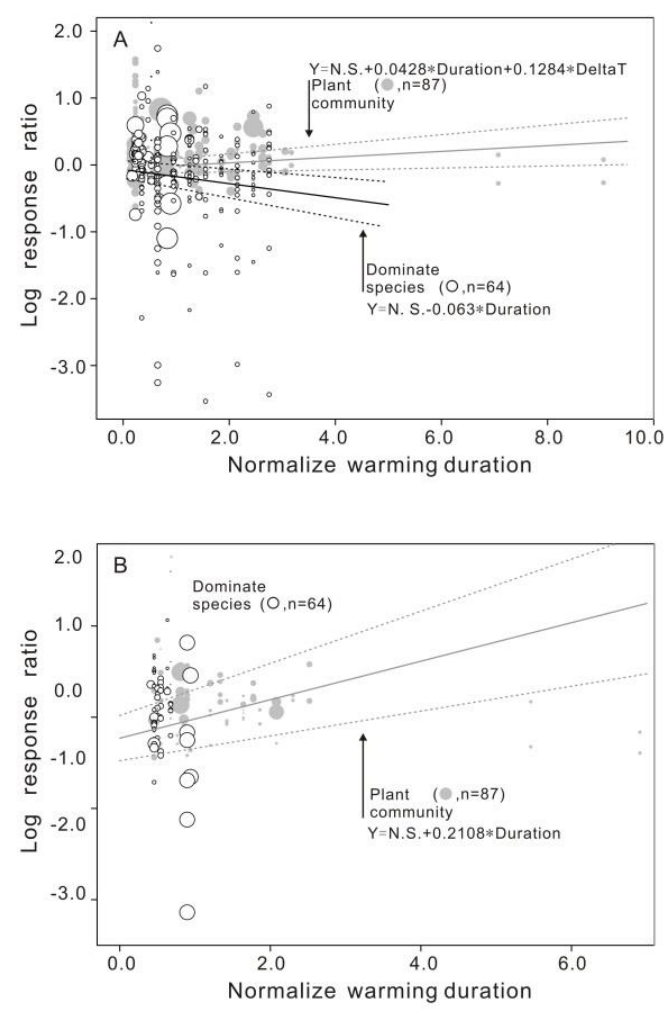
Figure 4. The effect of warming magnitudes (Delta T ) and warming duration (Warm D ) on warming-induced biomass accumulation of plant community (gray circle, Biomass CW ) and its dominant species (open circle, Biomass DS ). The size of the circle indicated the difference across Delta T . ( A ): Above-ground biomass (AGB); ( B ): Below-ground biomass (BGB). Corresponding equations showed the results of multiple mixed-effects meta-regression models, which considered Delta T , Warm D , and plant biomass. N.S.: no significance in “Intercept” of the model; n : the number of collected data. In addition, we ignored the equation for BGB of dominant species, as that model was not significant for both “Intercept” and “Slope”.